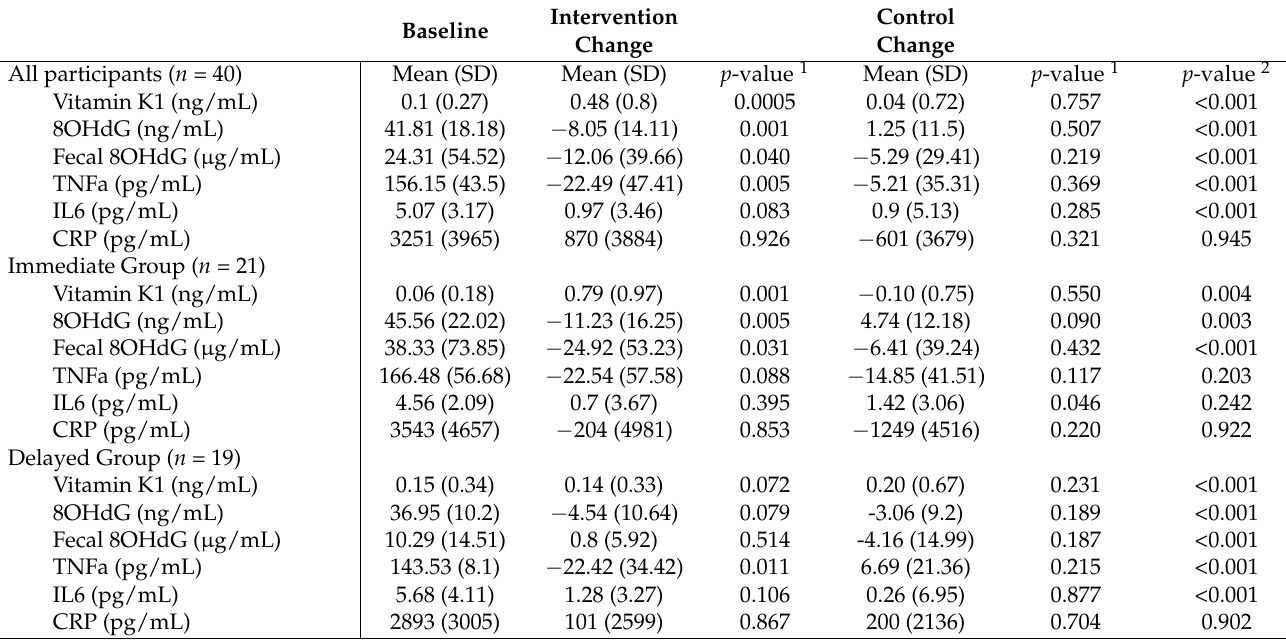
Table 2. Changes in circulating biomarkers of participants in a randomized controlled crossover high green leafy vegetable dietary intervention.